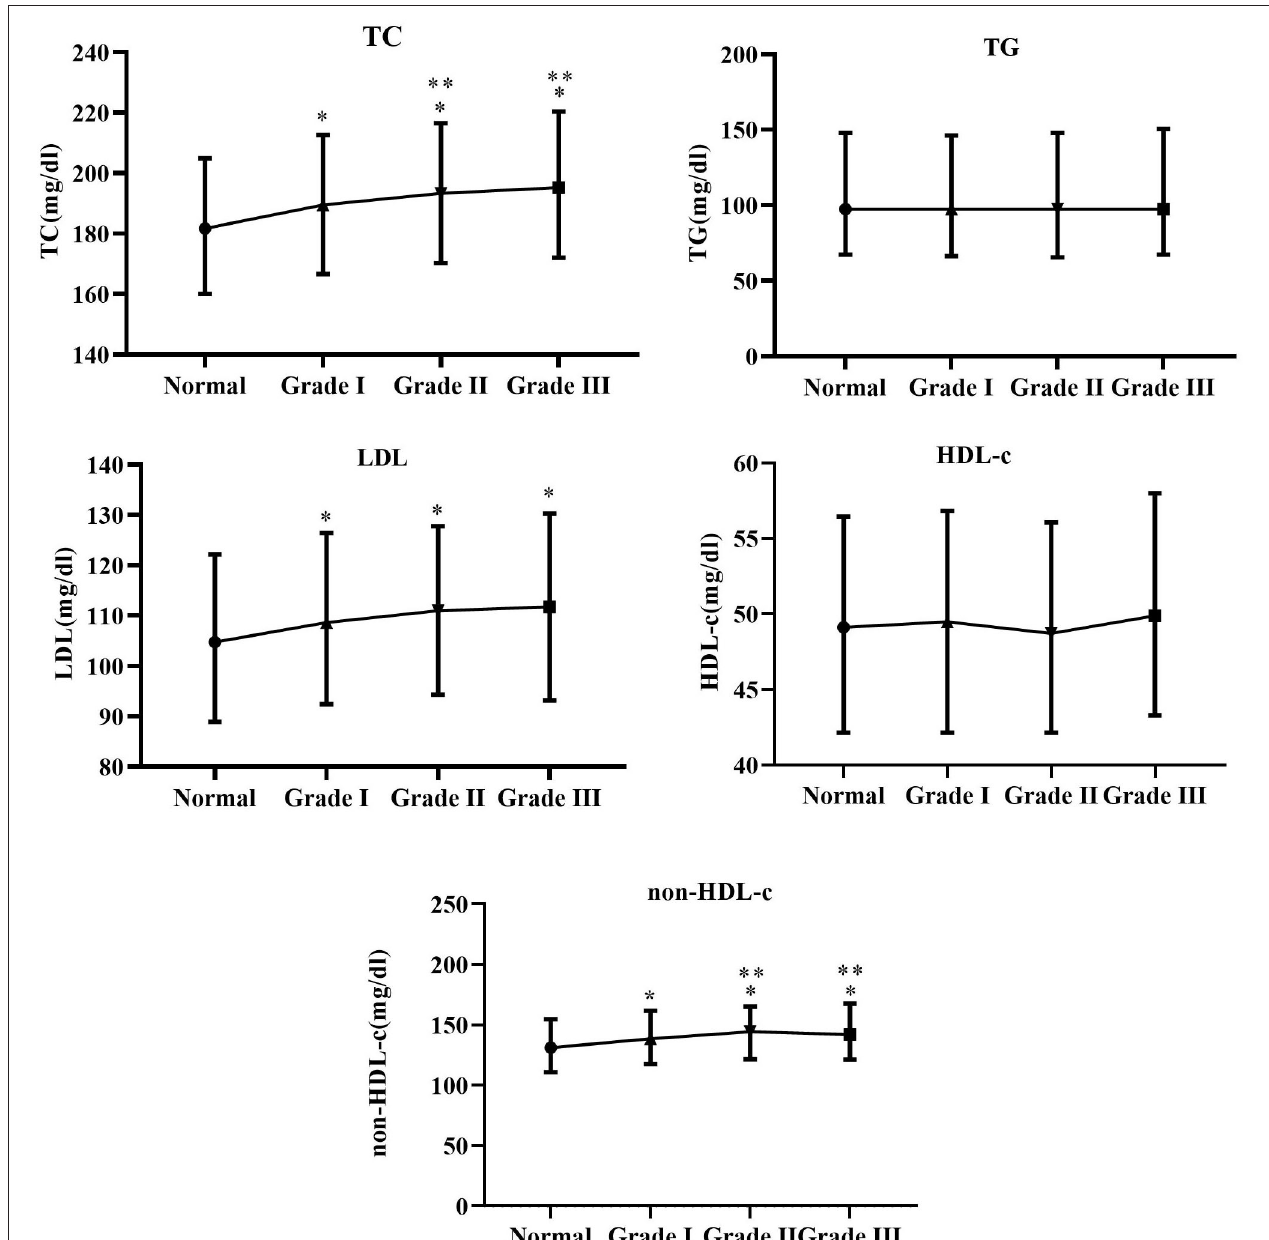
FIGURE 2 | Between-group differences in TC, TG, LDL-c, HDL-c, and non-HDL at different blood pressure levels. *Indicates Grade I, Grade II and Grade III compared with normal group with p -value < 0.05. **Indicates Grade II and Grade III compared with Grade I with p -value <